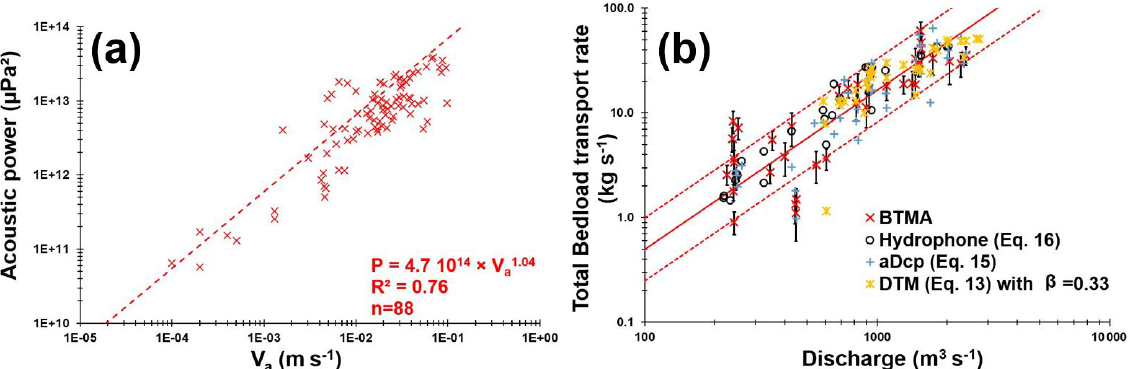
Figure 7. (a) Acoustic power as a function of apparent bedload velocity. (b) Cross-section-integrated bedload transport rates as a function of